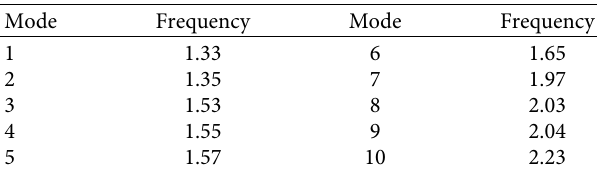
Figure 9: The contraction joint model. Table 1: Dynamic characteristics of the Baihetan arch dam- foundation system